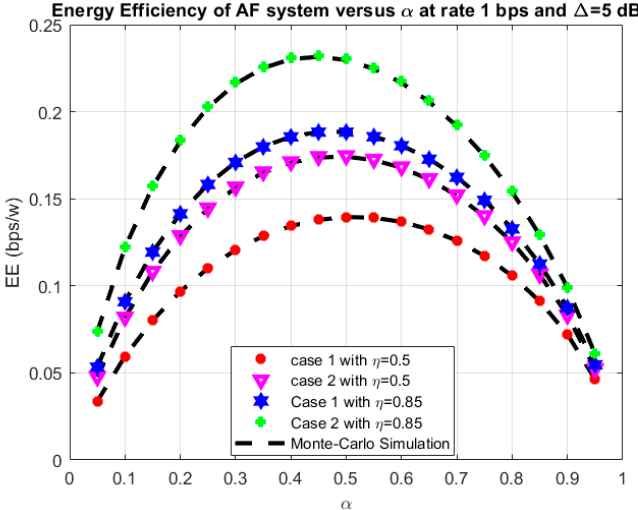
Figure 8. Energy e ffi ciency (EE) versus α Figure 8. Energy efficiency (EE) versus α .